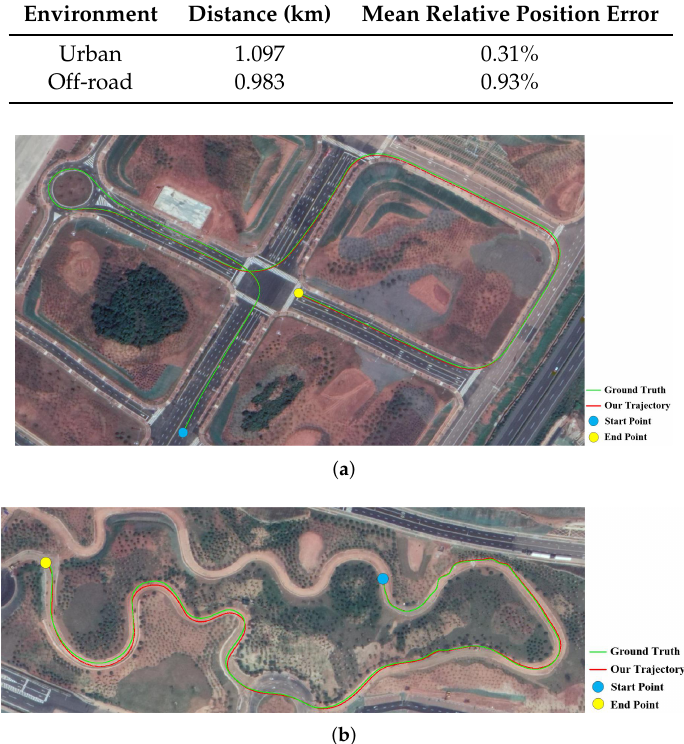
Table 5. Error comparison of diverse environments.